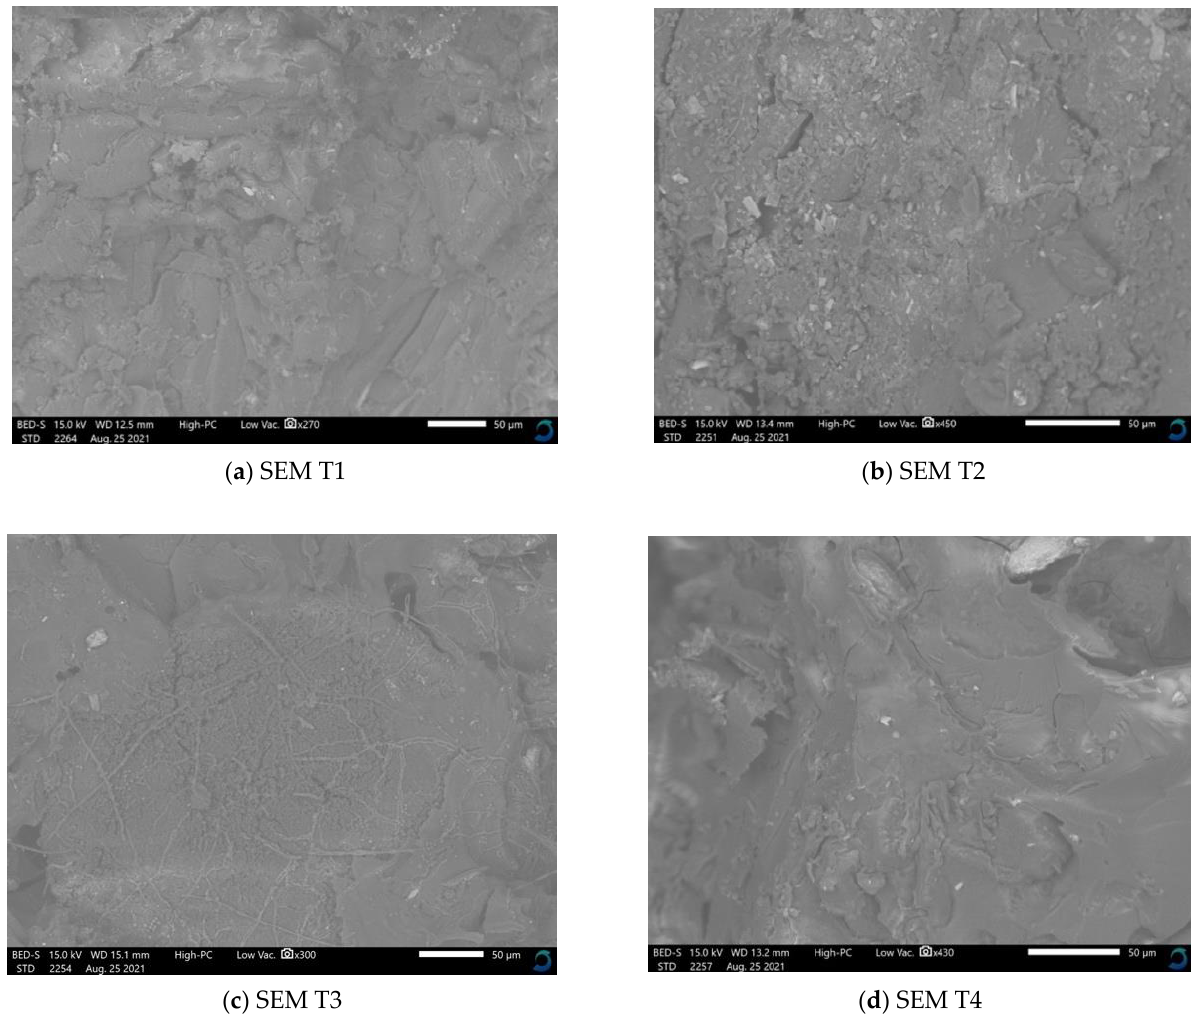
Figure 7. SEM analysis of particleboard ( a ) T1, ( b ) T2, ( c ) T3, and ( d ) T4.